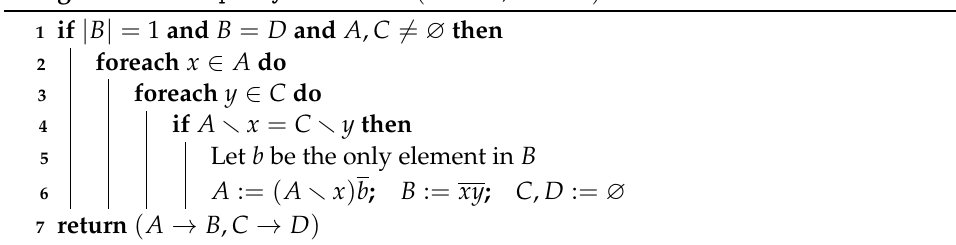
Algorithm 7: Simplify-MixUnUnit ( A